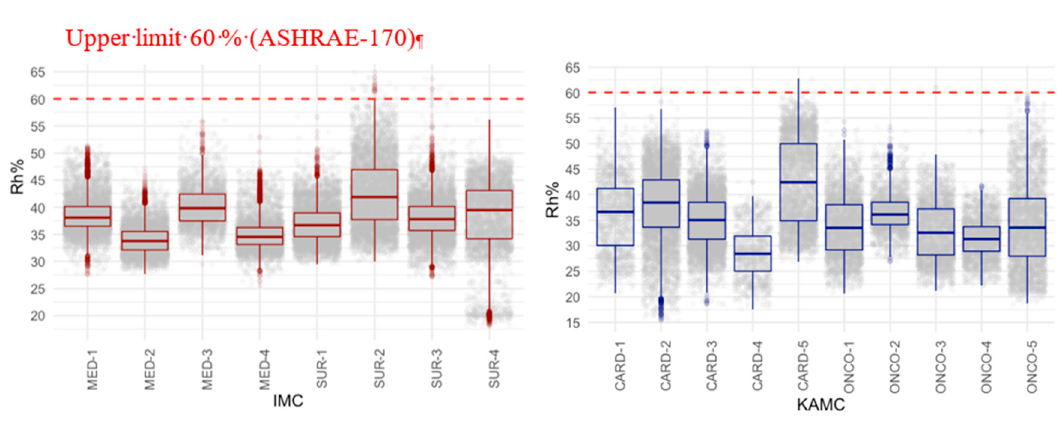
Figure 6. Relative humidity measurements for a four month period in both hospitals. The red dashed line refers to an upper acceptable limit of 60% proposed by ASHRAE-170. Note: room ID is just a random identification code and does not refer to room number.